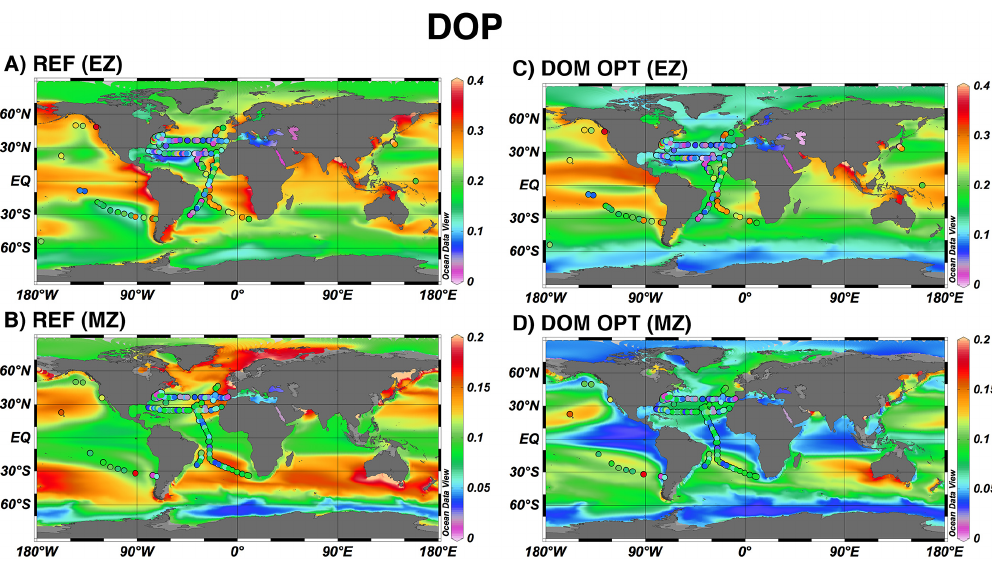
Figure 5. Plots of simulated total [DOP] (µM; colored contours) with observations (colored dots) for the REF simulation at (a) the surface (EZ) and (b) 200m (MZ), and for the DOM OPT simulation at (c) the surface (EZ) and (d) 200m (MZ).